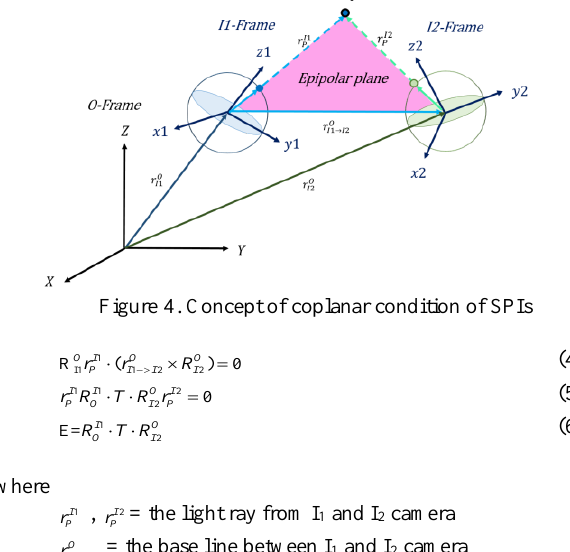
Figure 4. Concept of coplanar condition of